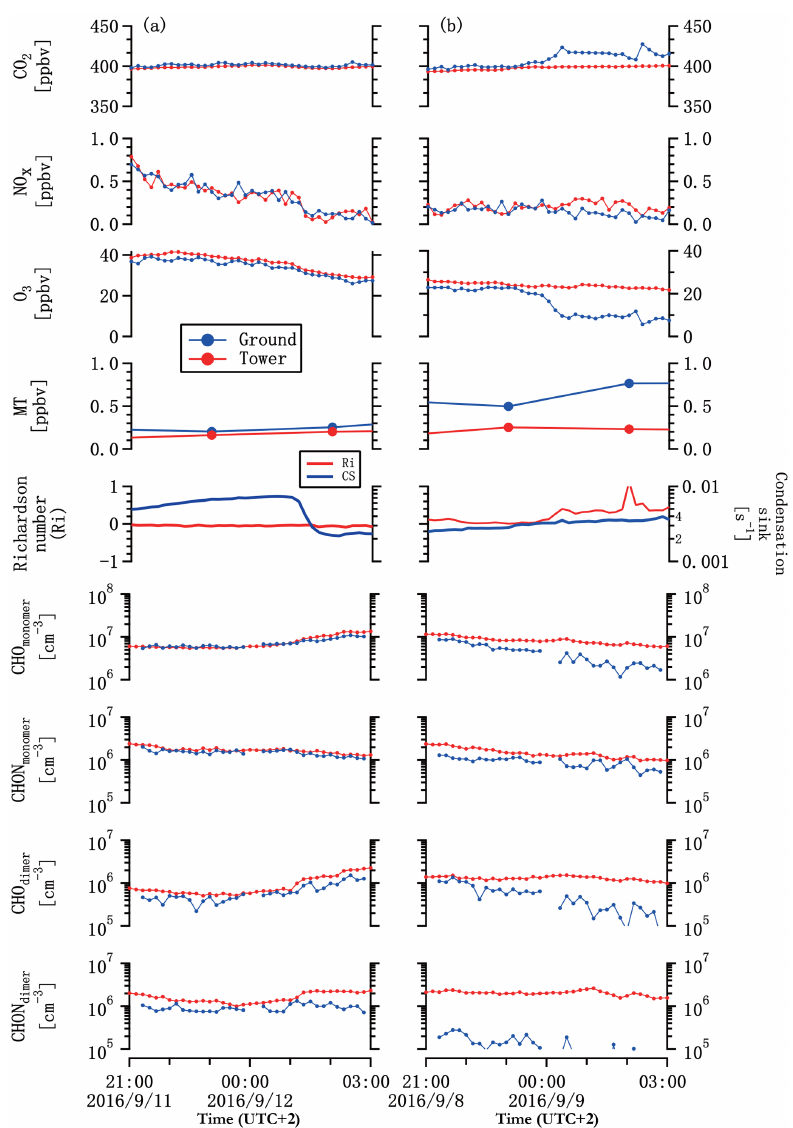
Figure 5. (a) Time series of ground and tower concentrations of CO 2 , NO x , O 3 , MT, and selected HOM groups in the selected non-inversion night (11 September) and (b) inversion night (8 September) types. Ri is calculated with the meteorology data of the ground and tower levels. CS is determined based on the aerosol data measured at 8m above ground